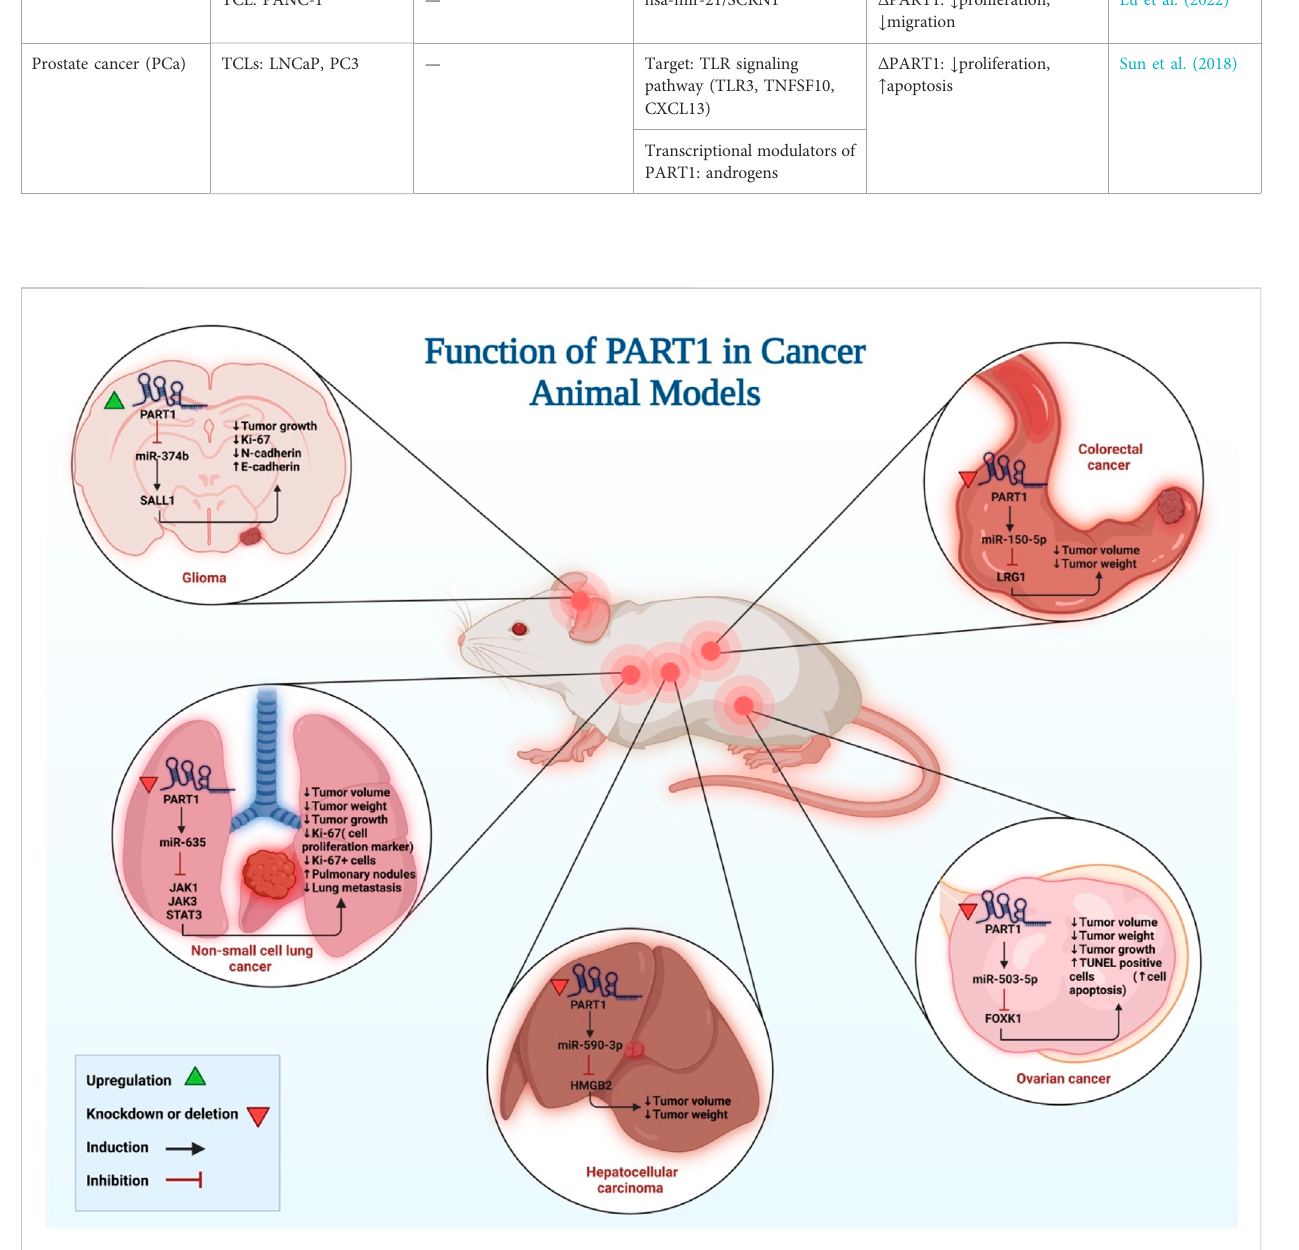
Frontiers in Cell and Developmental